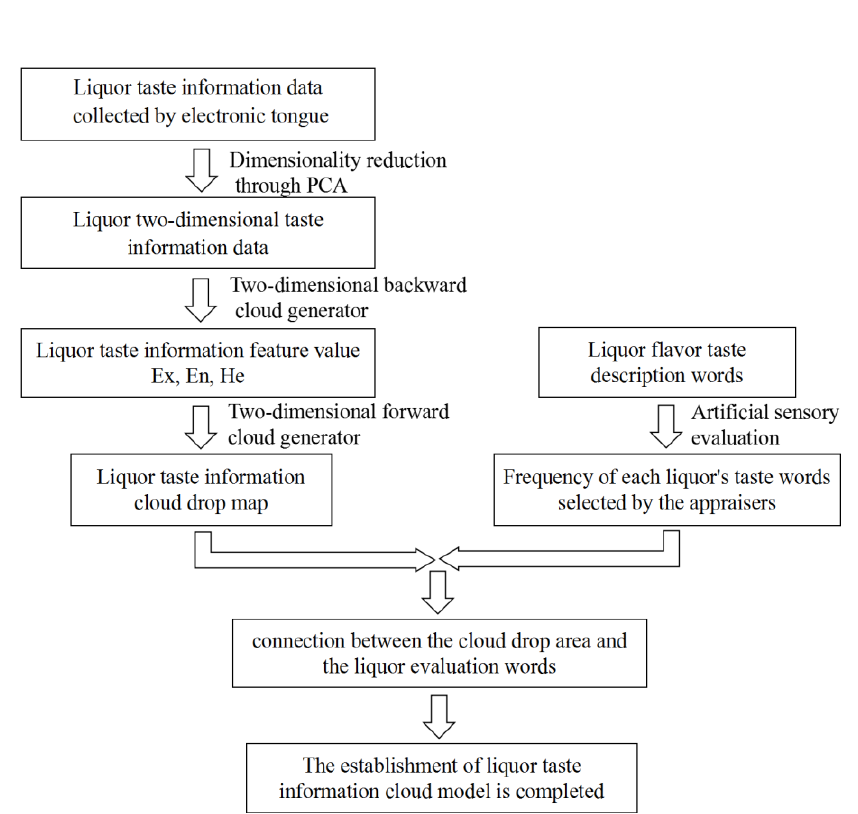
Figure A1. Flow chart of liquor taste information cloud model construction. Table A1. Regional corresponding language.